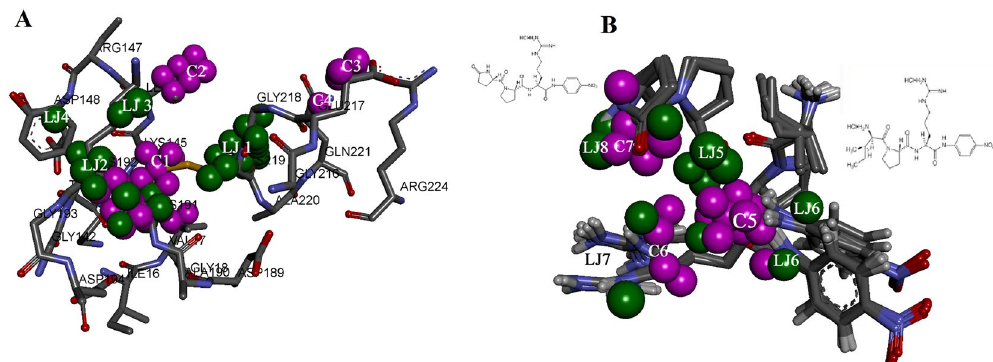
Figure 6. The IEDs of the best QSAR model with negative rc that are crucial for enzyme activity were mapped on the active site of the enzyme to locate important E-S interactions. ( A ) Represents the LJ (green) and C (pink) IEDs on the CEPs of active site of the enzymes and ( B ) represents the same on the substrates. The 2D structures of the substrate S-2366 (left) and S-2288 (right) represent the binding conformations of pyroGlu-Pro and H-D- Ile-Pro of the substrates in the active site. This conformational change is one of the crucial differences observed in the active site that defines the specificity of the